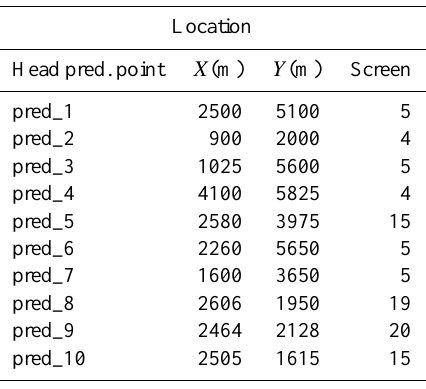
Table 4. Head and head recovery prediction points and screened layer.